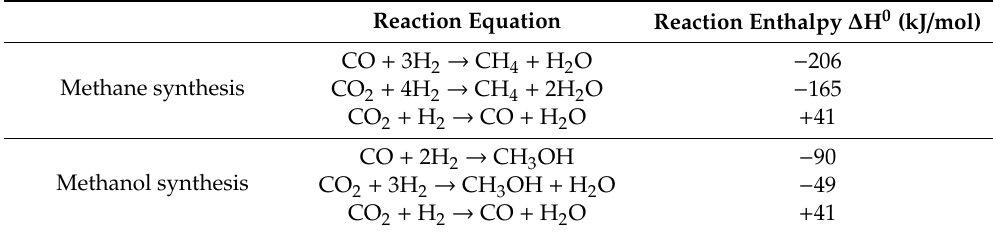
Table 2. Reaction equations for the methane and methanol synthesis of CO and CO 2